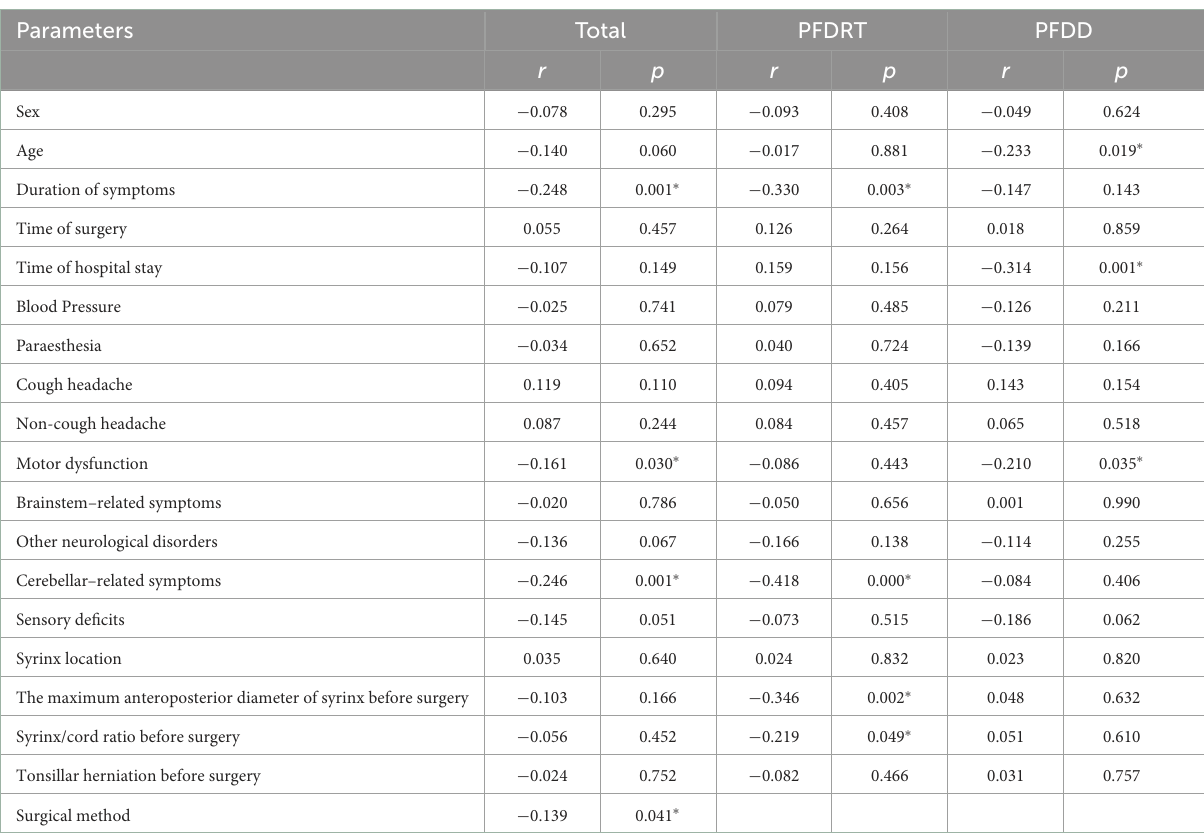
TABLE 3 CCOS bivariate correlation